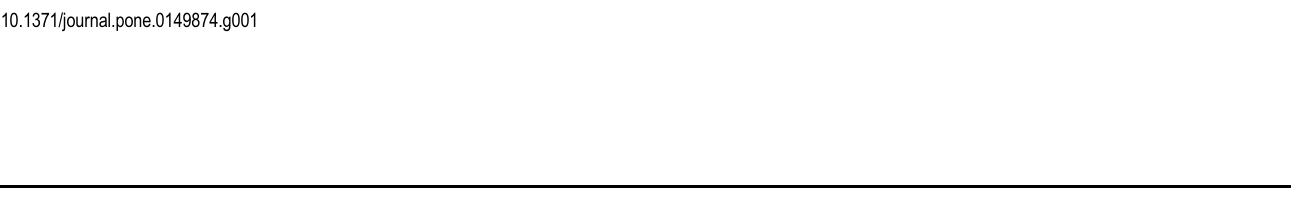
PLOS ONE | DOI:10.1371/journal.pone.0149874 February 22,